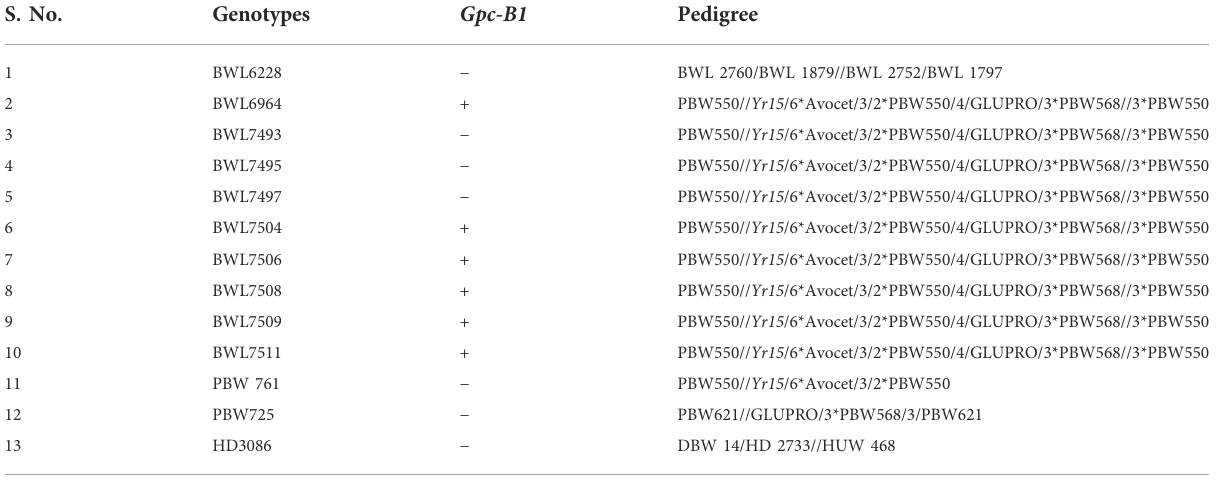
+ indicates the presence of Gpc-B1 , gene and − indicates the absence of Gpc-B1 , gene. Genotype 1 is an advanced breeding line, the genotypes 2 – 10 are near-isogenic lines, and genotypes 11 – 13 are released wheat varieties.